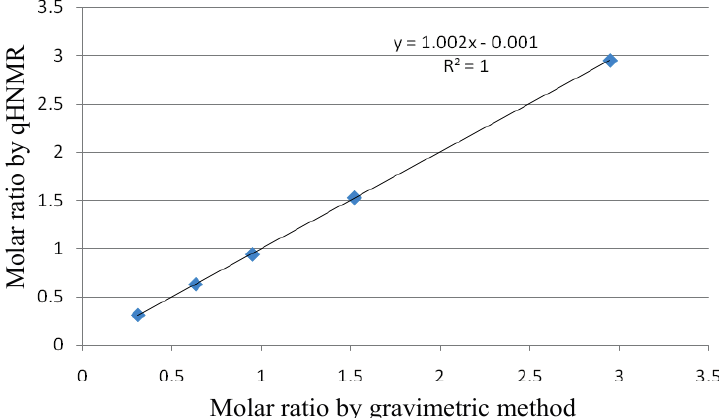
Figure 2. Linearity test of 4-demethylpodophyllotoxin: theoretical and experimental molar ratio of the standard